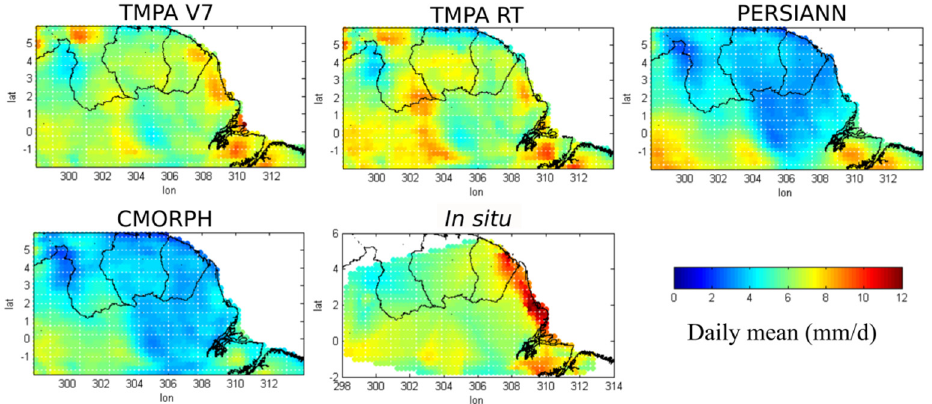
Figure 2. Average daily precipitation (mm/d) from 2001–2012 for all four satellite products and triangulation-based linear interpolation for in situ stations. TMPA V7, Tropical Rainfall Measuring Mission Multisatellite Precipitation Analysis Version 7; RT, real time.